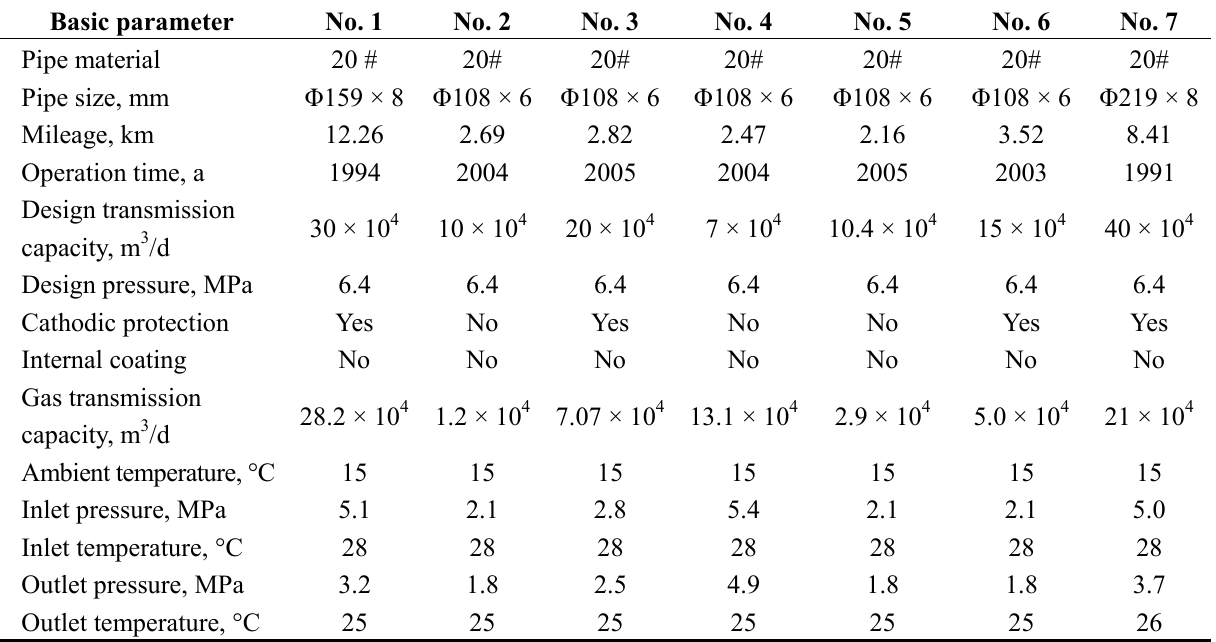
Table 3. The basic data on the seven gathering